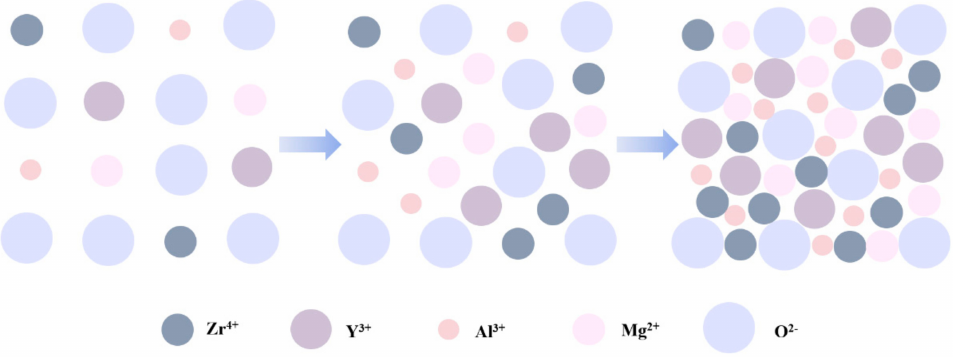
Figure 12. Sketch map of variations in the atomic arrangement as the concentration